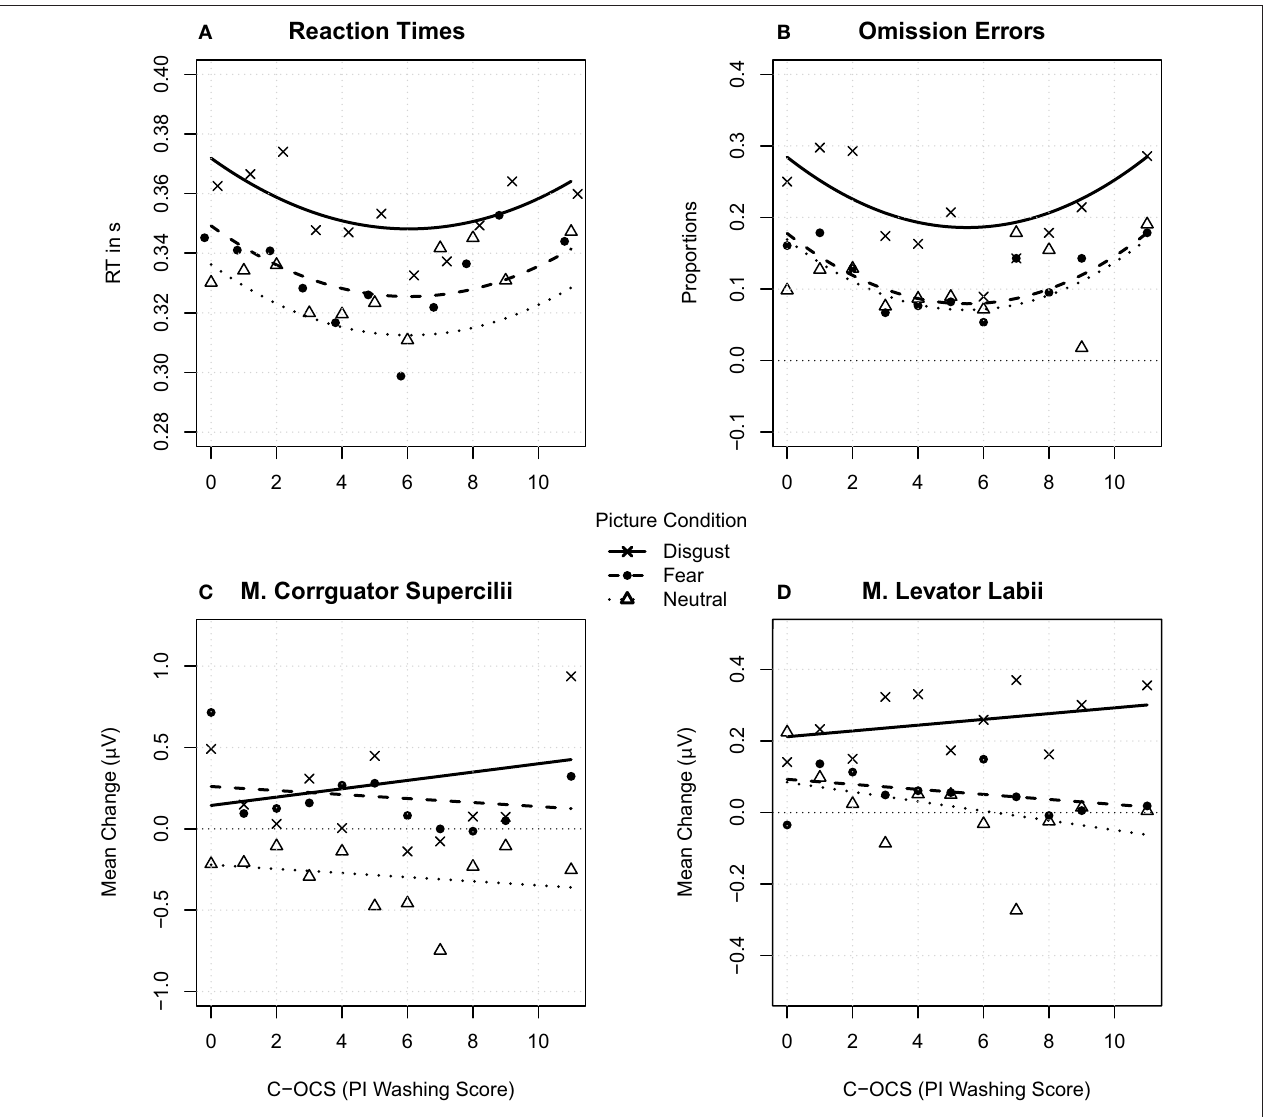
FIGURE 2 | In the upper-left (A) , the reaction times are shown; in the upper-right (B) , the proportions of the errors of omission are shown; in the lower-left (C) , the m. corrugator supercilii mean change activity is presented; and in the lower-right (D) , the m. levator labii mean change activity is presented. (A–D) show data in relation to the C-OC symptom score to the disgust, fear, and neutral category. The small dots represent the aggregated mean values for each emotion category and each PI Washing Score.